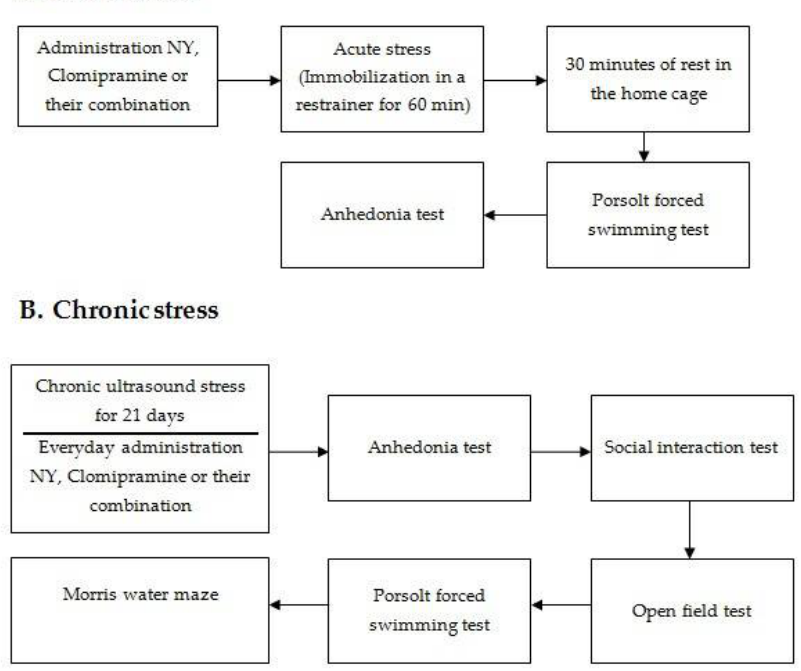
Figure 1. Schematic illustration of the designs of experiments: animals with acute stress ( A ) and chronic stress ( B )